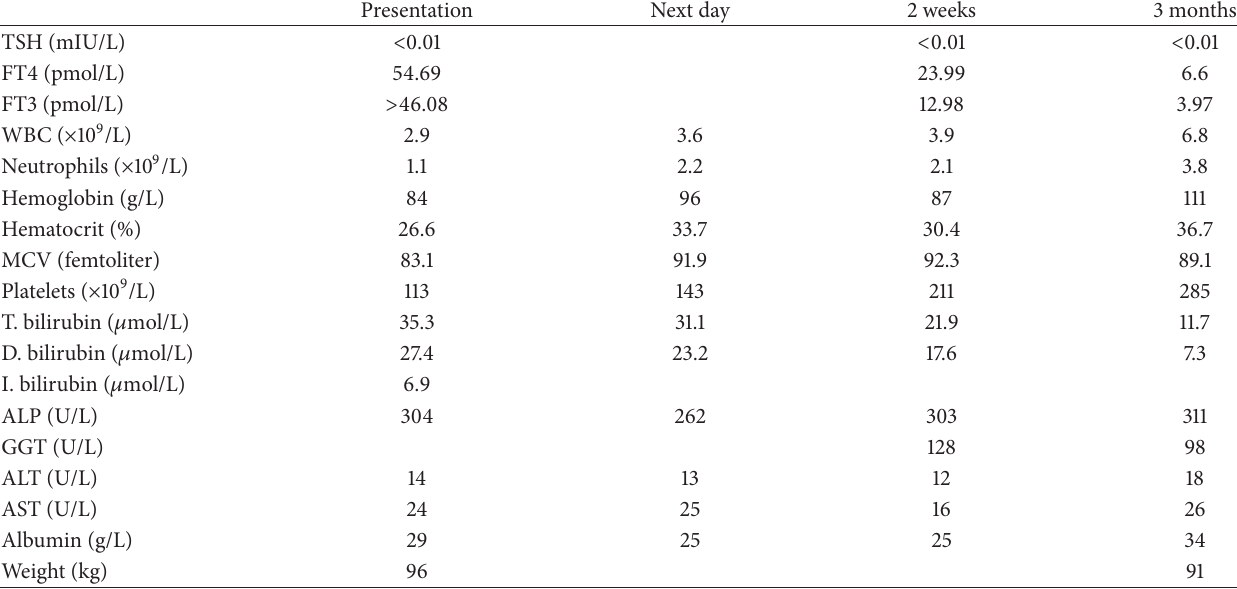
Table 1: Laboratory investigations at presentation and in the 3 months following carbimazole treatment.